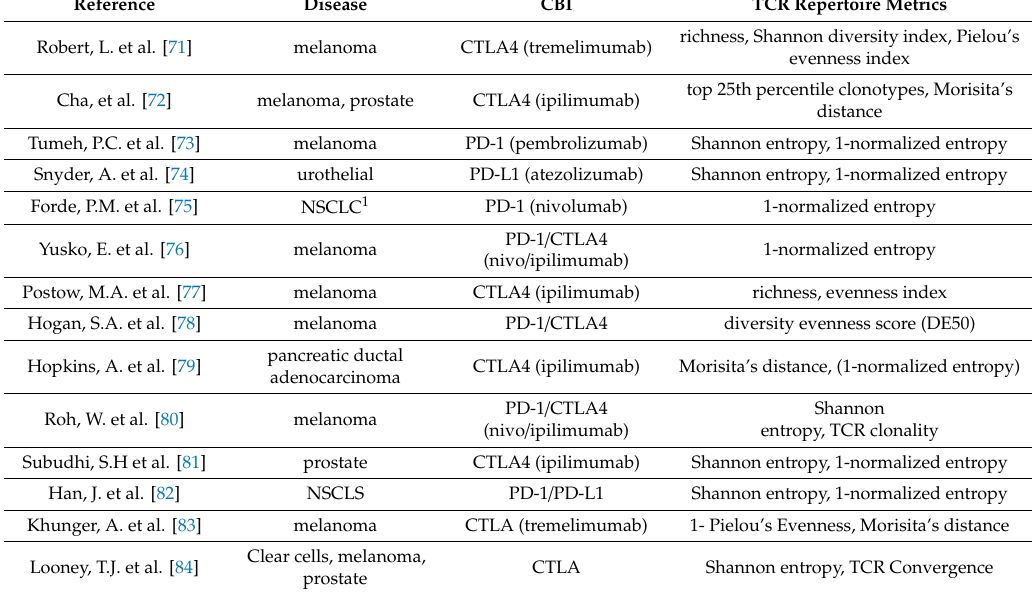
Table 3. TCR repertoire metrics used as biomarkers in major checkpoint blockade immunotherapy